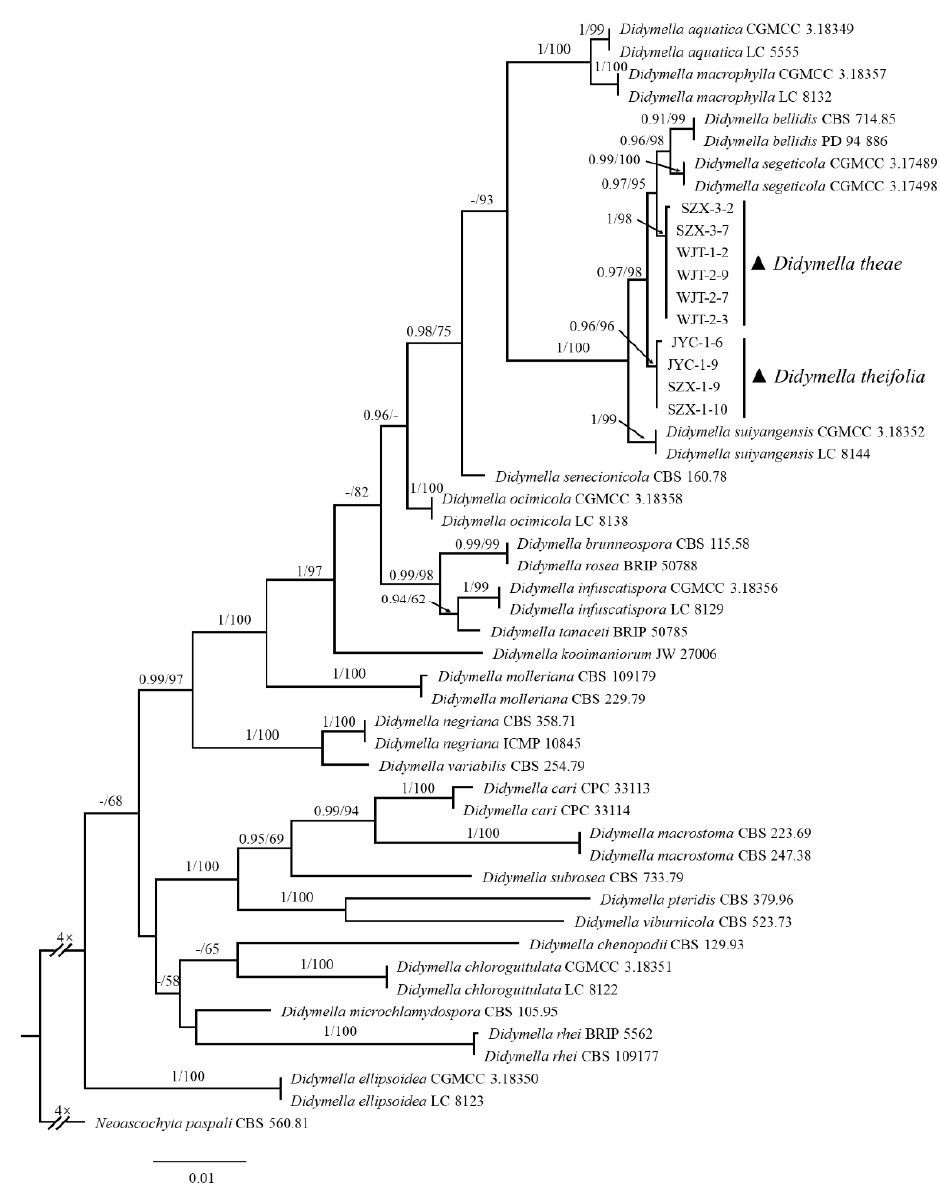
Figure 3. Phylogenetic tree generated by Bayesian inference (BI) and maximum likelihood (ML) based on combined ITS, LSU, rpb2, and tub2 sequences of Didymella theae , D. theifolia, and the 25 species that have the closest phylogenetic relationship with them. Neoascochyta paspali (CBS 560.81) was selected as the outgroup. The ML tree was used to show the phylogenetic relationships of isolates and reference strains. Bayesian posterior probability (PP ≥ 0.90) and ML bootstrap support values (ML ≥ 50%) are shown at the nodes